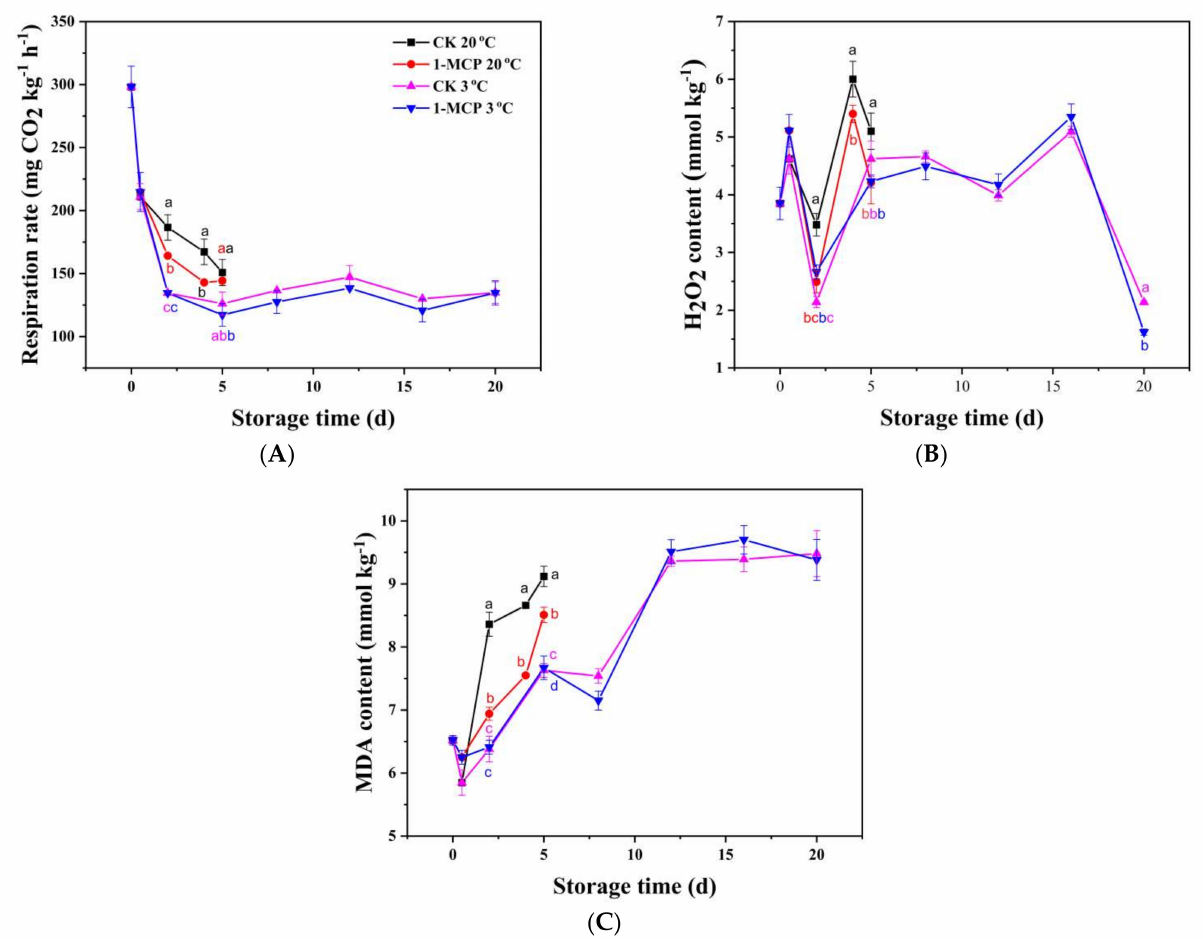
Figure 2. Respiration rate ( A ), H 2 O 2 content ( B ) and MDA content ( C ) of 1-MCP treated and untreated chives during storage at 20 ◦ C and 3 ◦ C. Data are expressed as the mean of triplicate samples. Vertical bars represent the standard errors of the means. The different letters at each time point indicate a difference among the chives